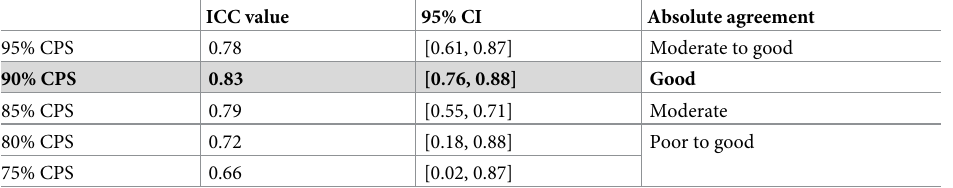
Table 4. Absolute agreement (ICC values and their 95% confidence intervals) between CPS values estimated by the raters and with the NLME method for five different cut-off values of CPS.